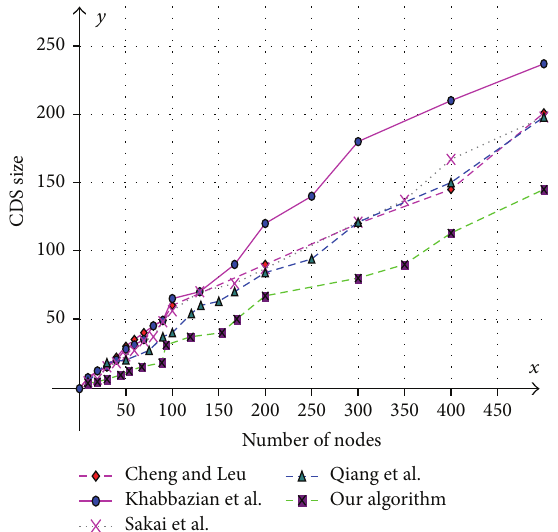
Figure 10: Number of nodes versus CDS size (transmission range = 50 mts and speed = 5mts/s).